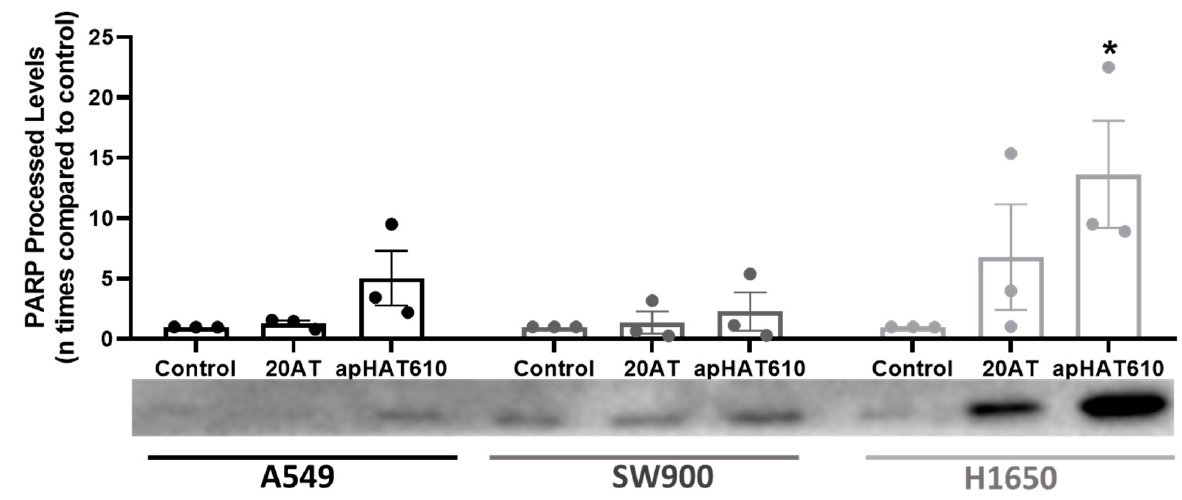
Figure 7. Effect of apHAT610 on apoptosis in lung cell lines. Immunodetection with the specific antibody by 7.5% SDS-PAGE PARP was processed to detect the proteolytic activity of caspase 3 after transfection of A549, SW900, and H1650 lines with apHAT610 and the control aptamer 20AT. The activity of this protease resulted in characteristic proteolysis patterns with specific 89 kDa fragments. The graph represents the mean ± SEM of three independent experiments (* p < 0.05 with respect to the control). The image corresponds to a representative assay.